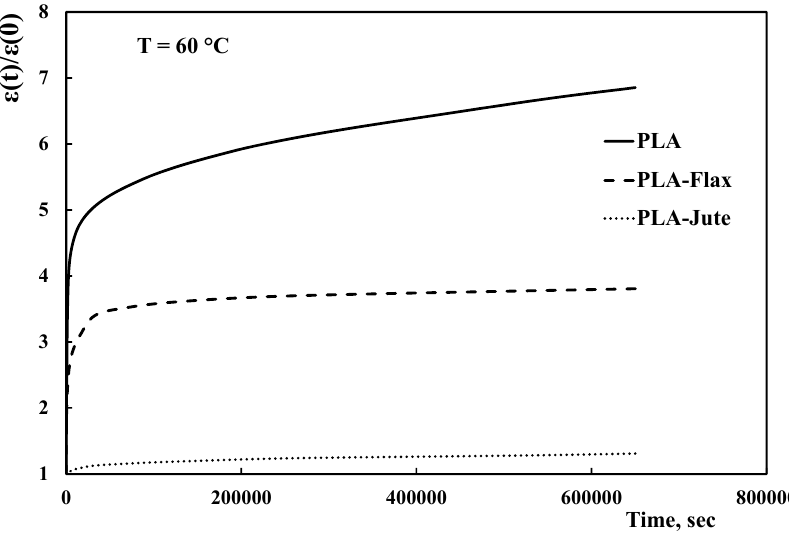
Figure 5. Normalized deformation versus time trends of PLA and related composites at 60 °C.